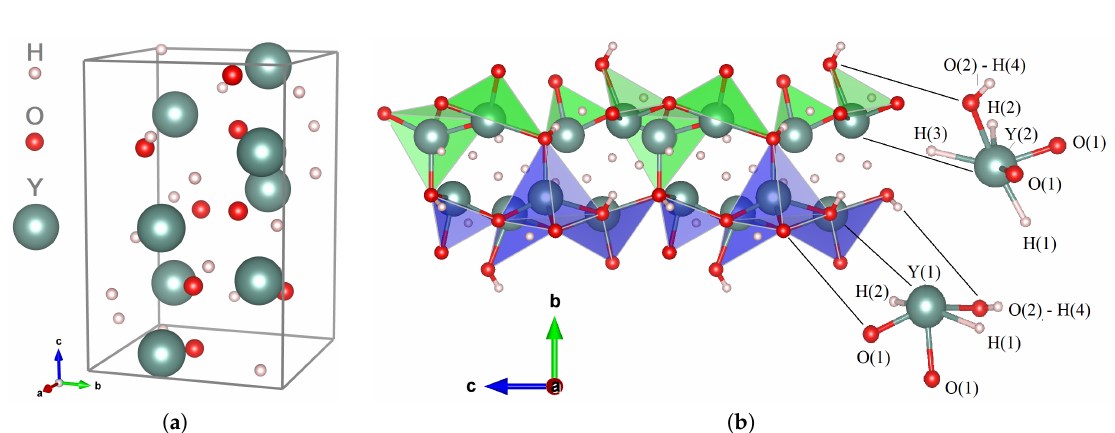
Figure 2. Predicted crystal structure of Y 2 H 3 O(OH): The structural parameters are given in Table 1. ( a ) A schematic view of the unit cell along the tetragonal c axis. ( b ) A characteristic pattern of polyhedral chains viewed along a